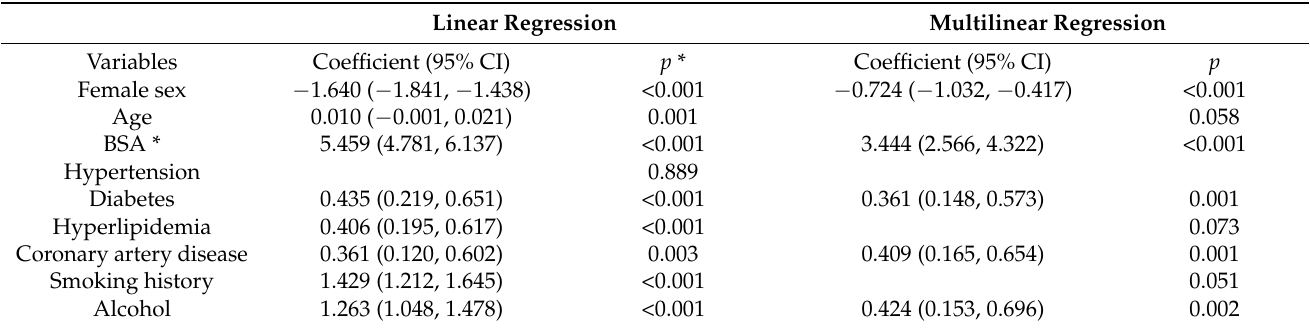
Table 4. Linear and multilinear regression of infrarenal aortic diameter with variables in the Korean